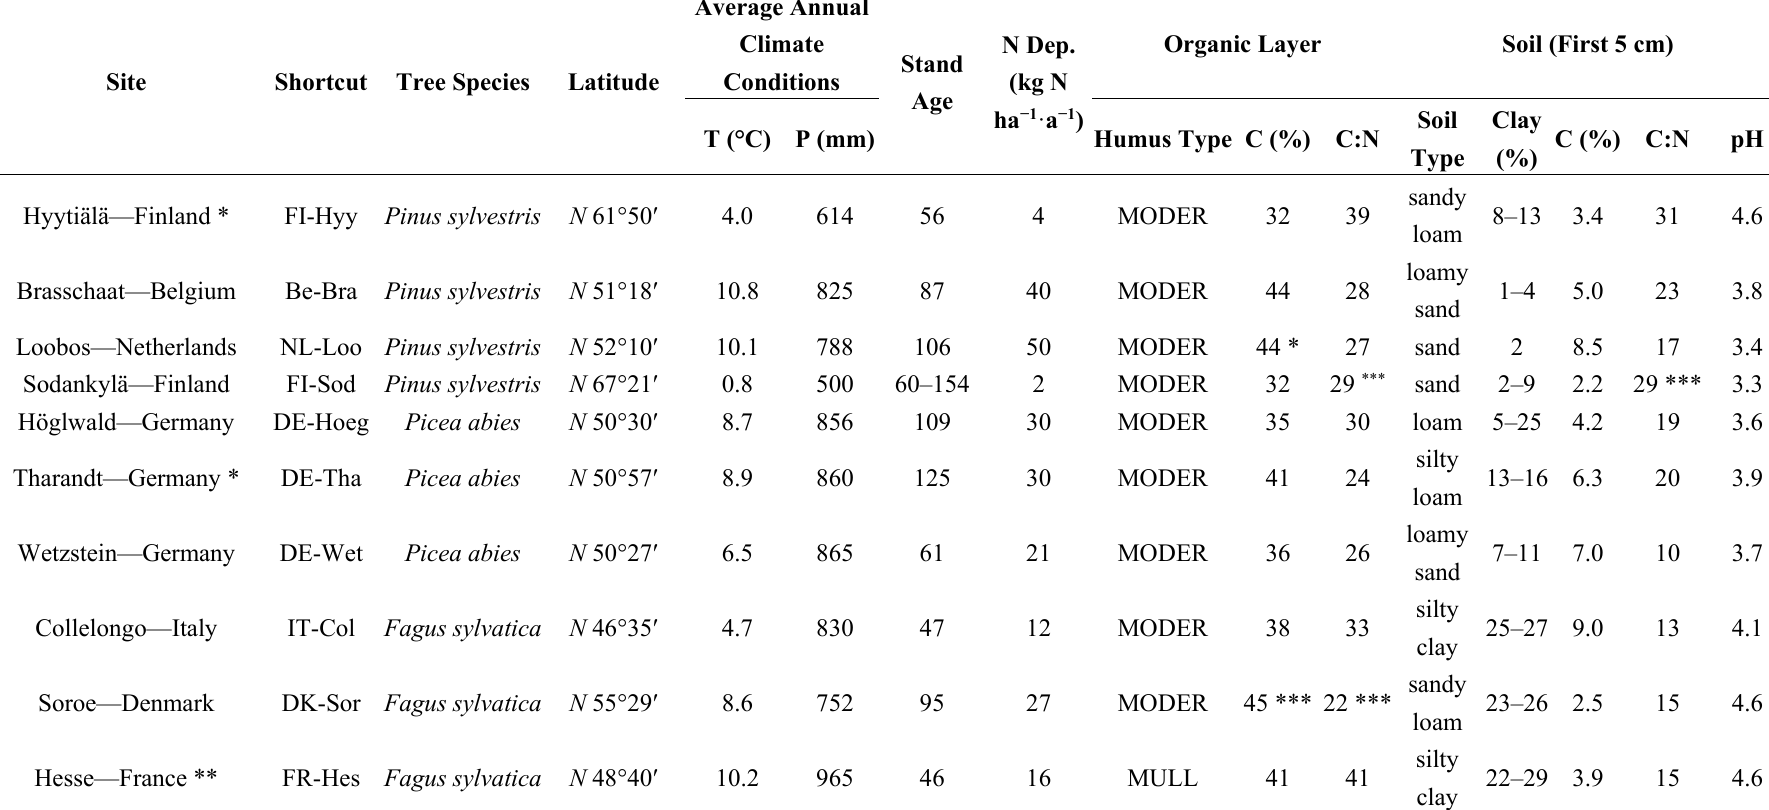
Table 1. Site characteristics of investigated forest ecosystems (soil type is arranged according FAO